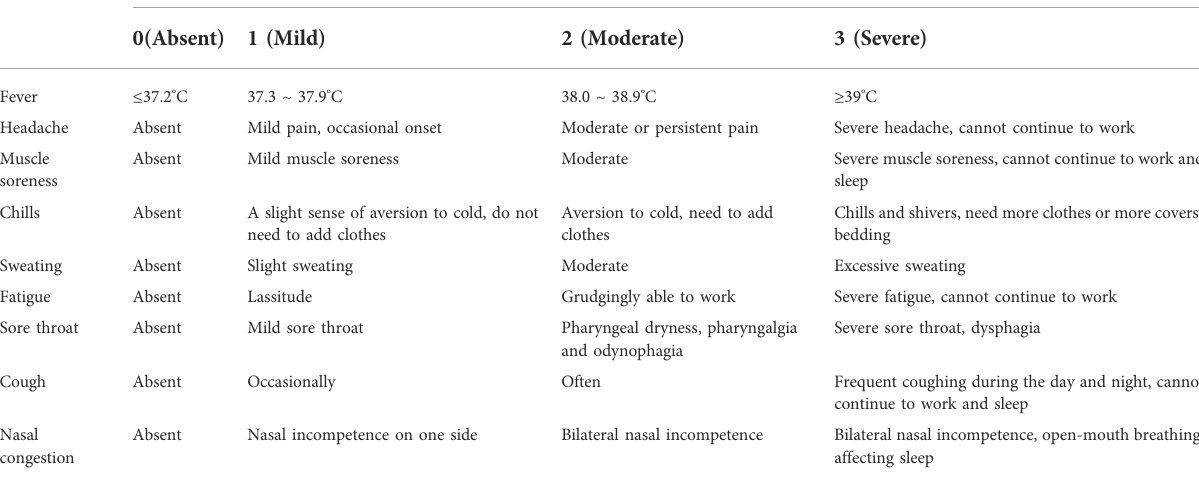
TABLE 1 In fl uenza symptom scoring criteria.